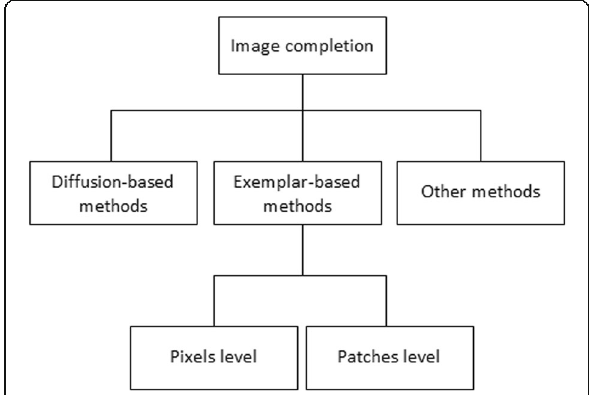
Fig. 1 The classification of image completion